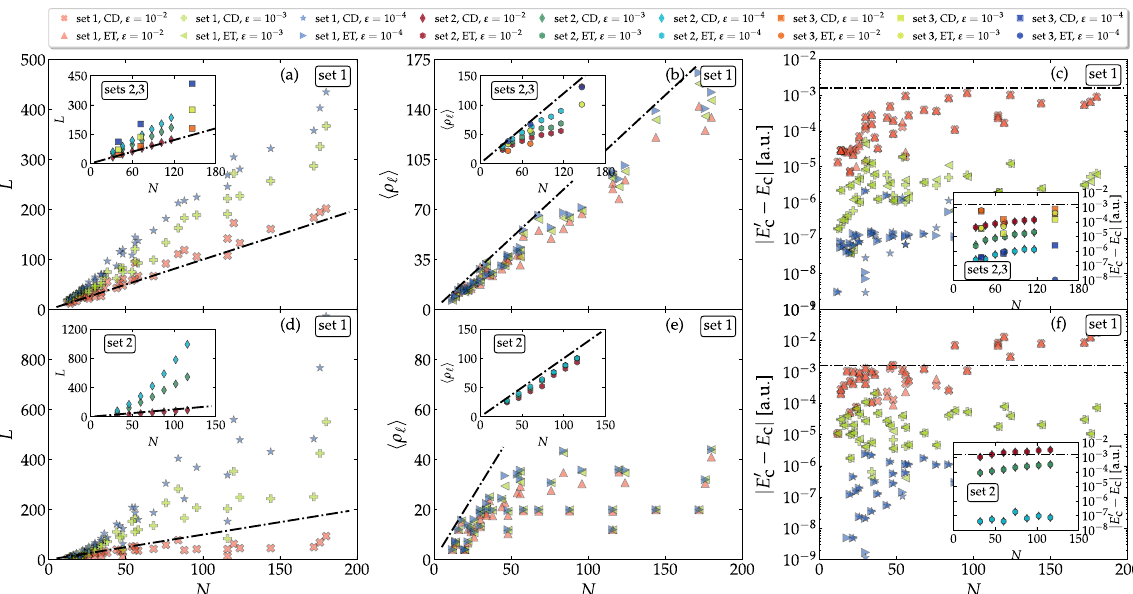
Fig. 1 Truncation results for H and τ . a Linear scaling of the number L of vectors with basis size N , in the low-rank approximation of H . (cid:3) E j in the ground-state correlation energy from the low-rank b Sublinear scaling of the average eigenvalue number 〈 ρ ℓ 〉 . c Error j E 0 c c approximation of H , compared with chemical accuracy (horizontal black line). Data points in all of the main fi gures comprise small molecules with fi xed size and increasingly large basis (set 1); insets show alkane chains with up to 8 C atoms (set 2) and iron – sulfur clusters of nitrogenase (set 3). Lines indicate N (left, middle) and the chemical accuracy (right). d – f Same as the upper panel, for the uCC operator τ , with 〉 averaged over μ . The symbol ε indicates ε = ε = ε 〈 ρ ℓ CD TH